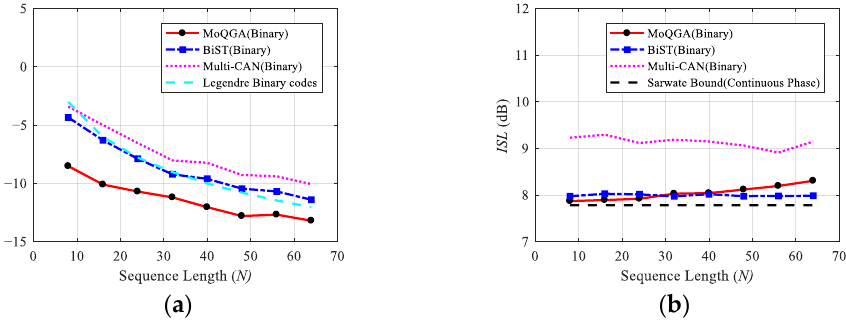
Figure 8. PSL and ISL values of MIMO radar binary phase code sequence set obtained by MoQGA and other methods under M = 3 and different code sequence length. ( a ) PSL ; ( b ) ISL .